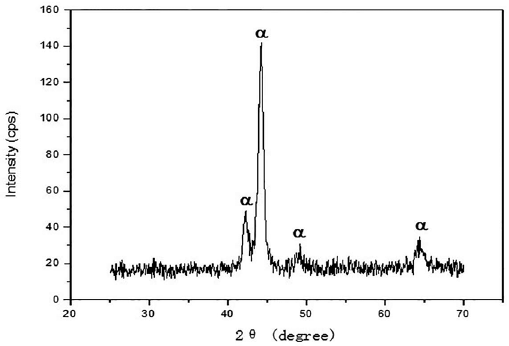
Figure 1: X-Ray diffraction curve of the FeAlCuCrCoMn target.